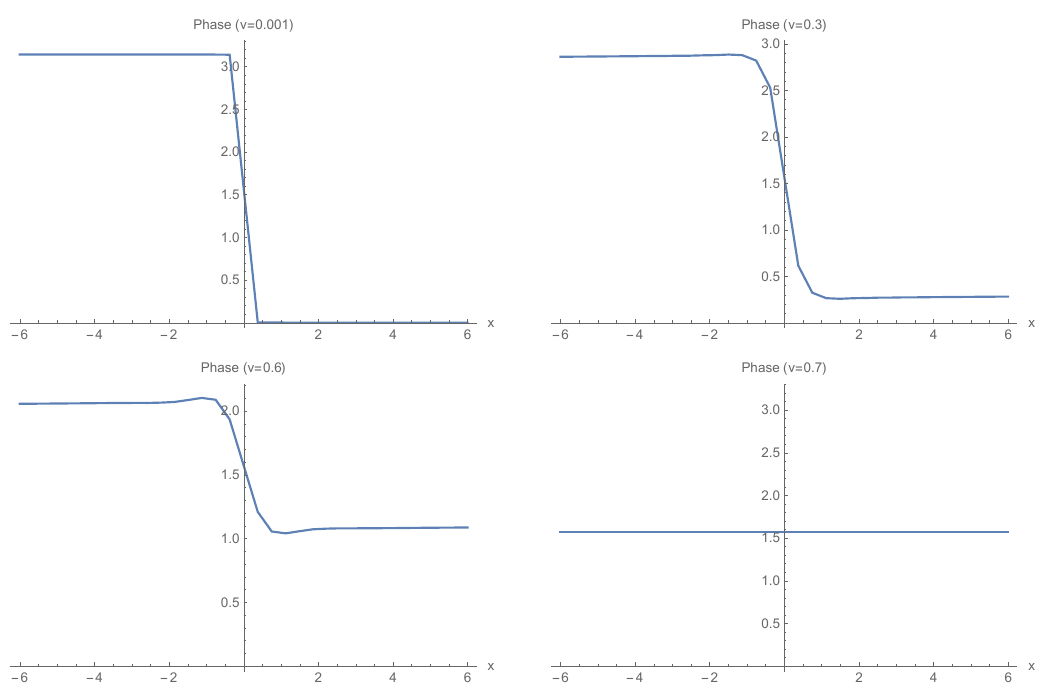
Figure 13 . The distributions of phase at di(cid:11)erent soliton speeds, under the standard quantization with the chemical potential (cid:22) = 5 : 5.